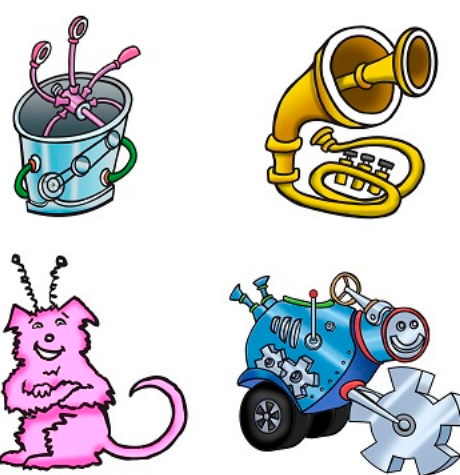
Figure 1. Visual referents used in the original word-learning paradigm [62].